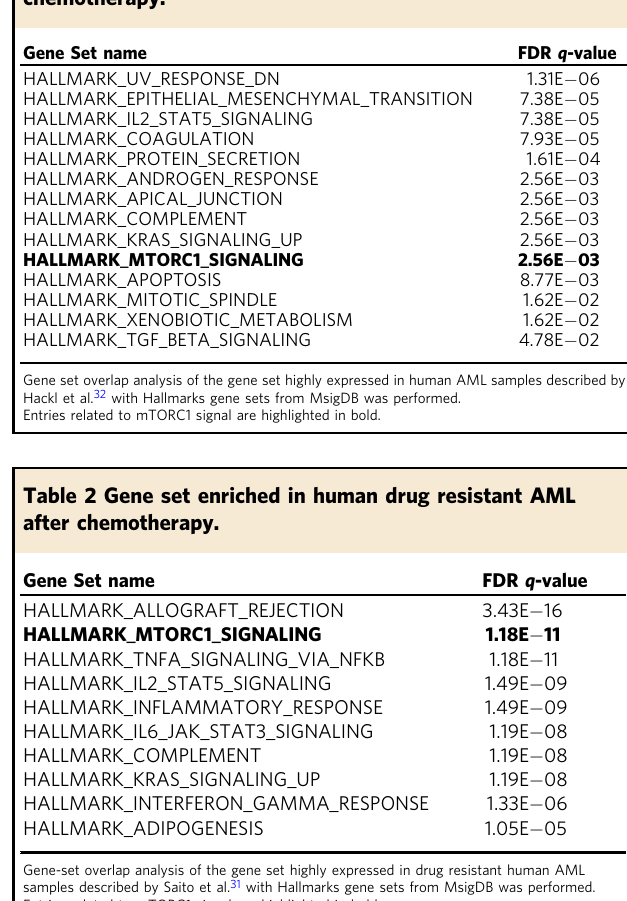
Table 1 Gene set enriched in human AML sample after chemotherapy.